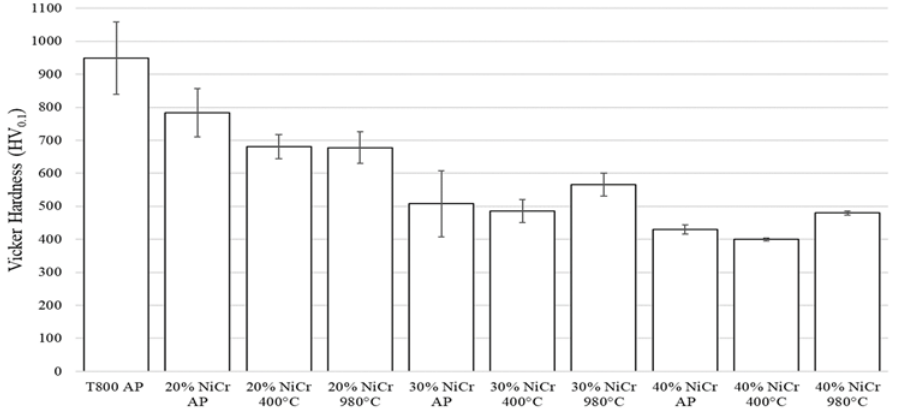
Figure 8. Vicker’s hardness results of as processed heat treatment (400 °C and 980 °C) of T800 and T800 + NiCr alloy chemistries.